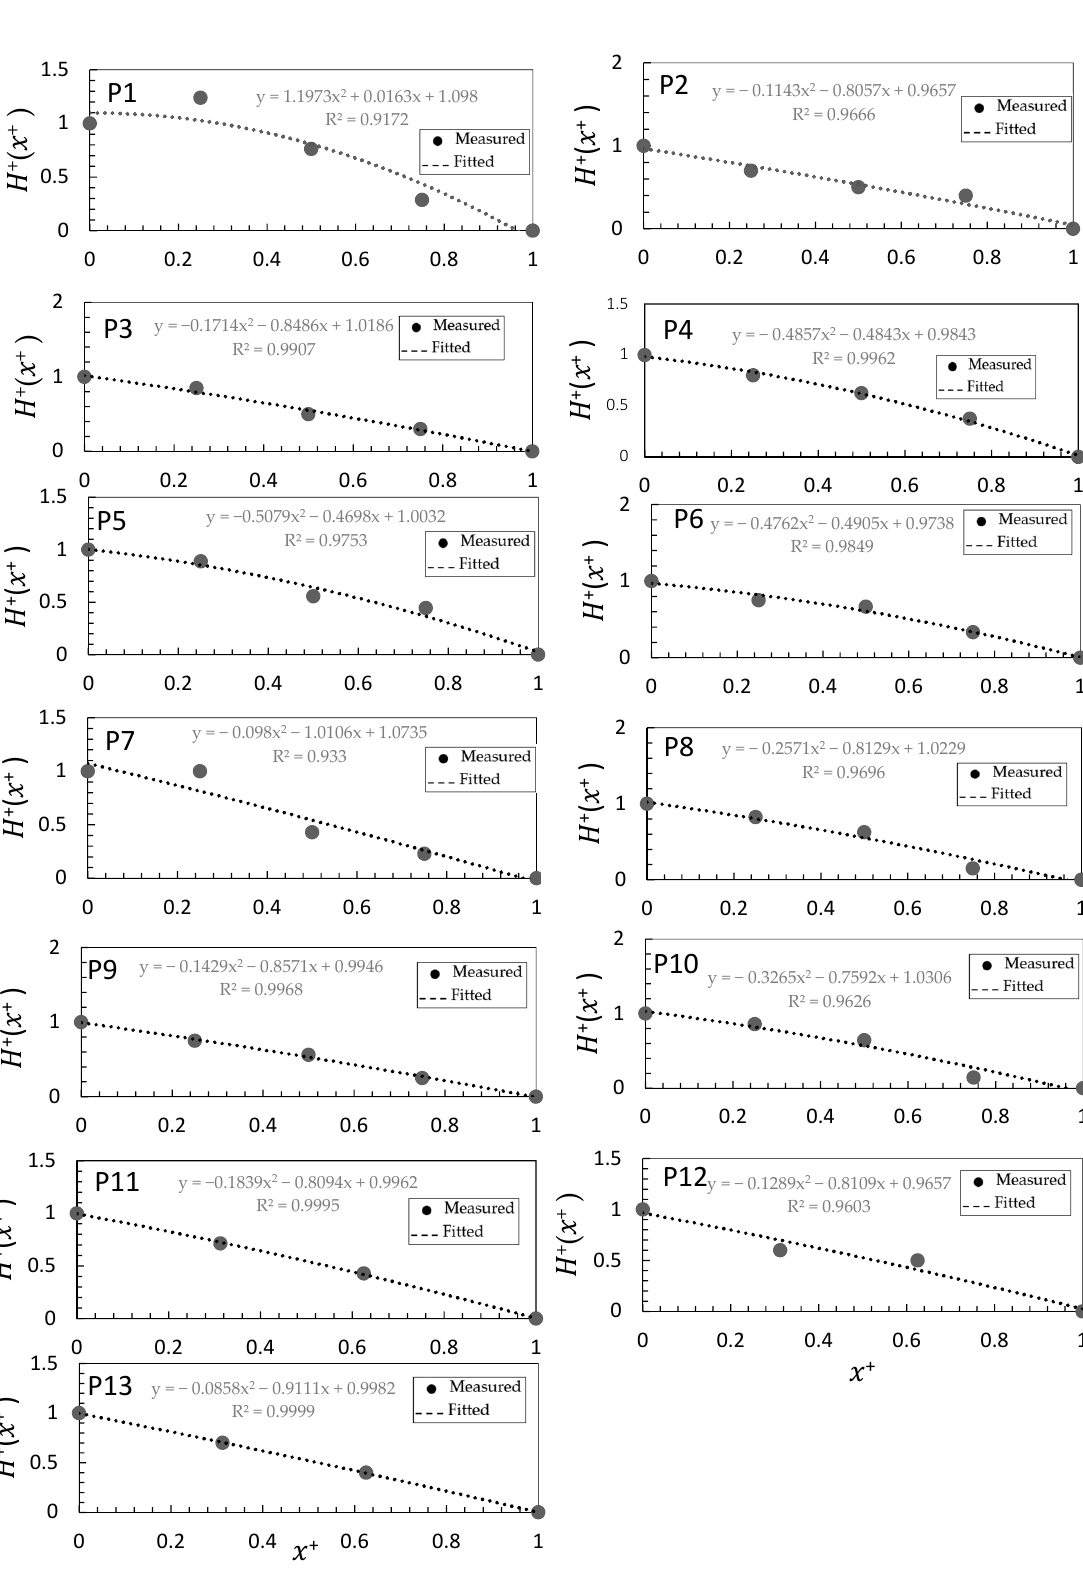
Figure 4. Comparison between measured and fitted normalized water surface profiles along the normalized distance (streamwise direction) for all vegetated patches.